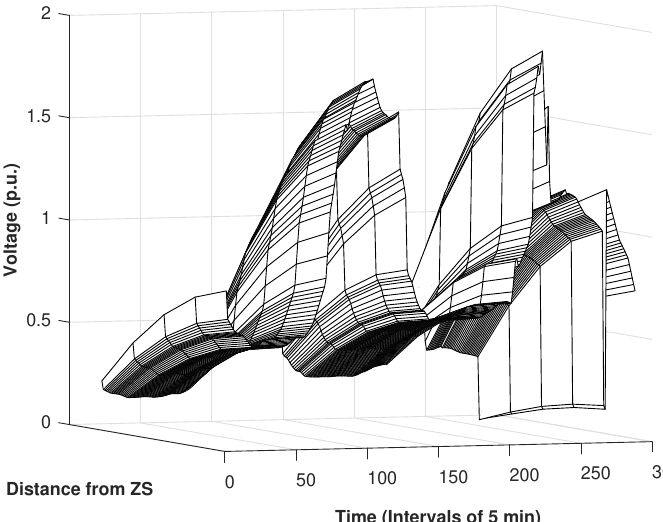
Figure 12. VUF in the LV network after using the proposed volt/var control